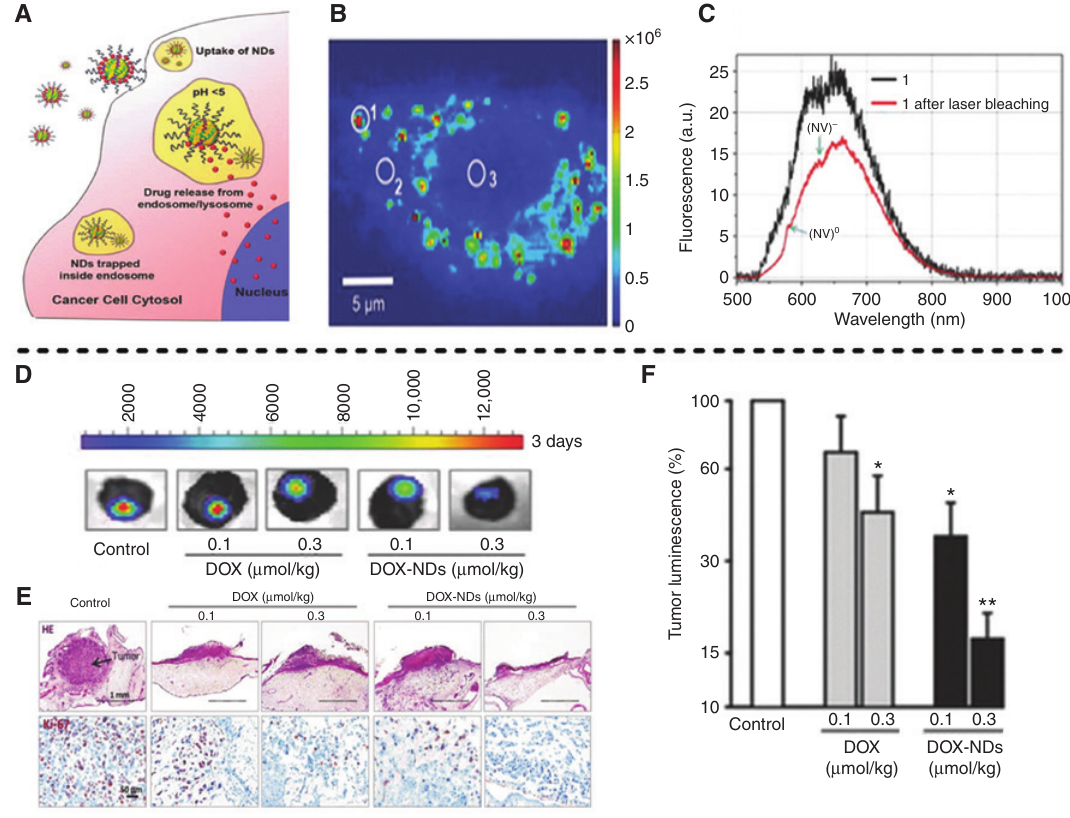
Figure 6: Biological applications of fluorescent nanodiamonds in drug delivery. (A) Demonstration of living cell uptake and drug release process of DOX-ND. (B) Fluorescence spectra of fluorescent DOX-NDs inside living (A549) cells. (C) Black curve represents the overlapping emission spectra of DOX and NV centers. The red curve illustrates the emission spectrum after laser bleaching of the DOX emission showing a clear NV center spectrum with NVo and NV peaks at 575 and 638 nm, respectively. (D) Human cancer xenografts treated with NDs-DOX after 3 days. (E) Breast cancer cells treated with DOX-ND over time. NDs-DOX treatment reduced the cancer cell proliferation in a dose-dependent manner. (F) Luminescence imaging analysis of tumor xenograft growth after 3 days treatment by NDs-DOX. *p < 0.05, **p < 0.01. Adapted from